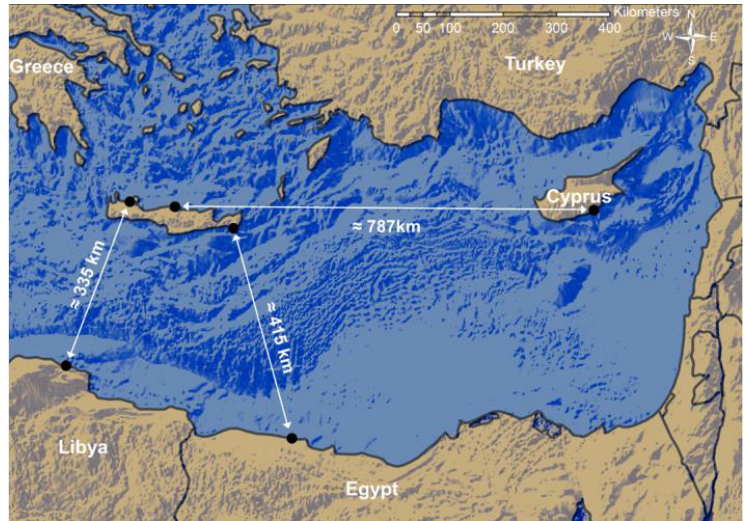
Figure 6. General view of the area under consideration.